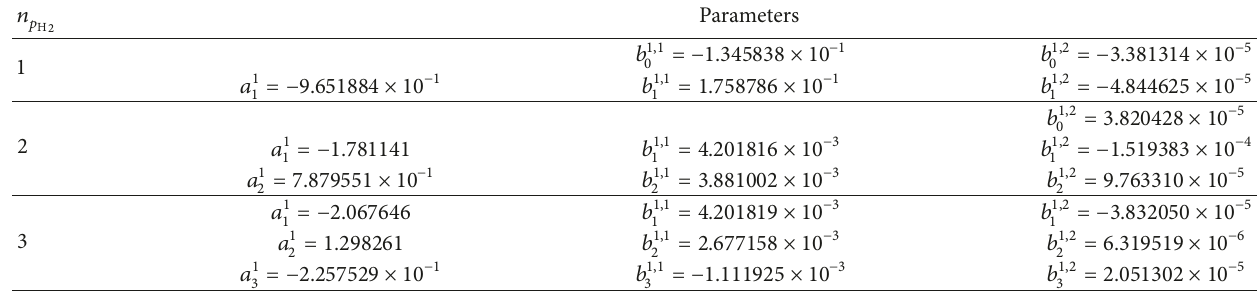
calculated by the second algorithm. H 2